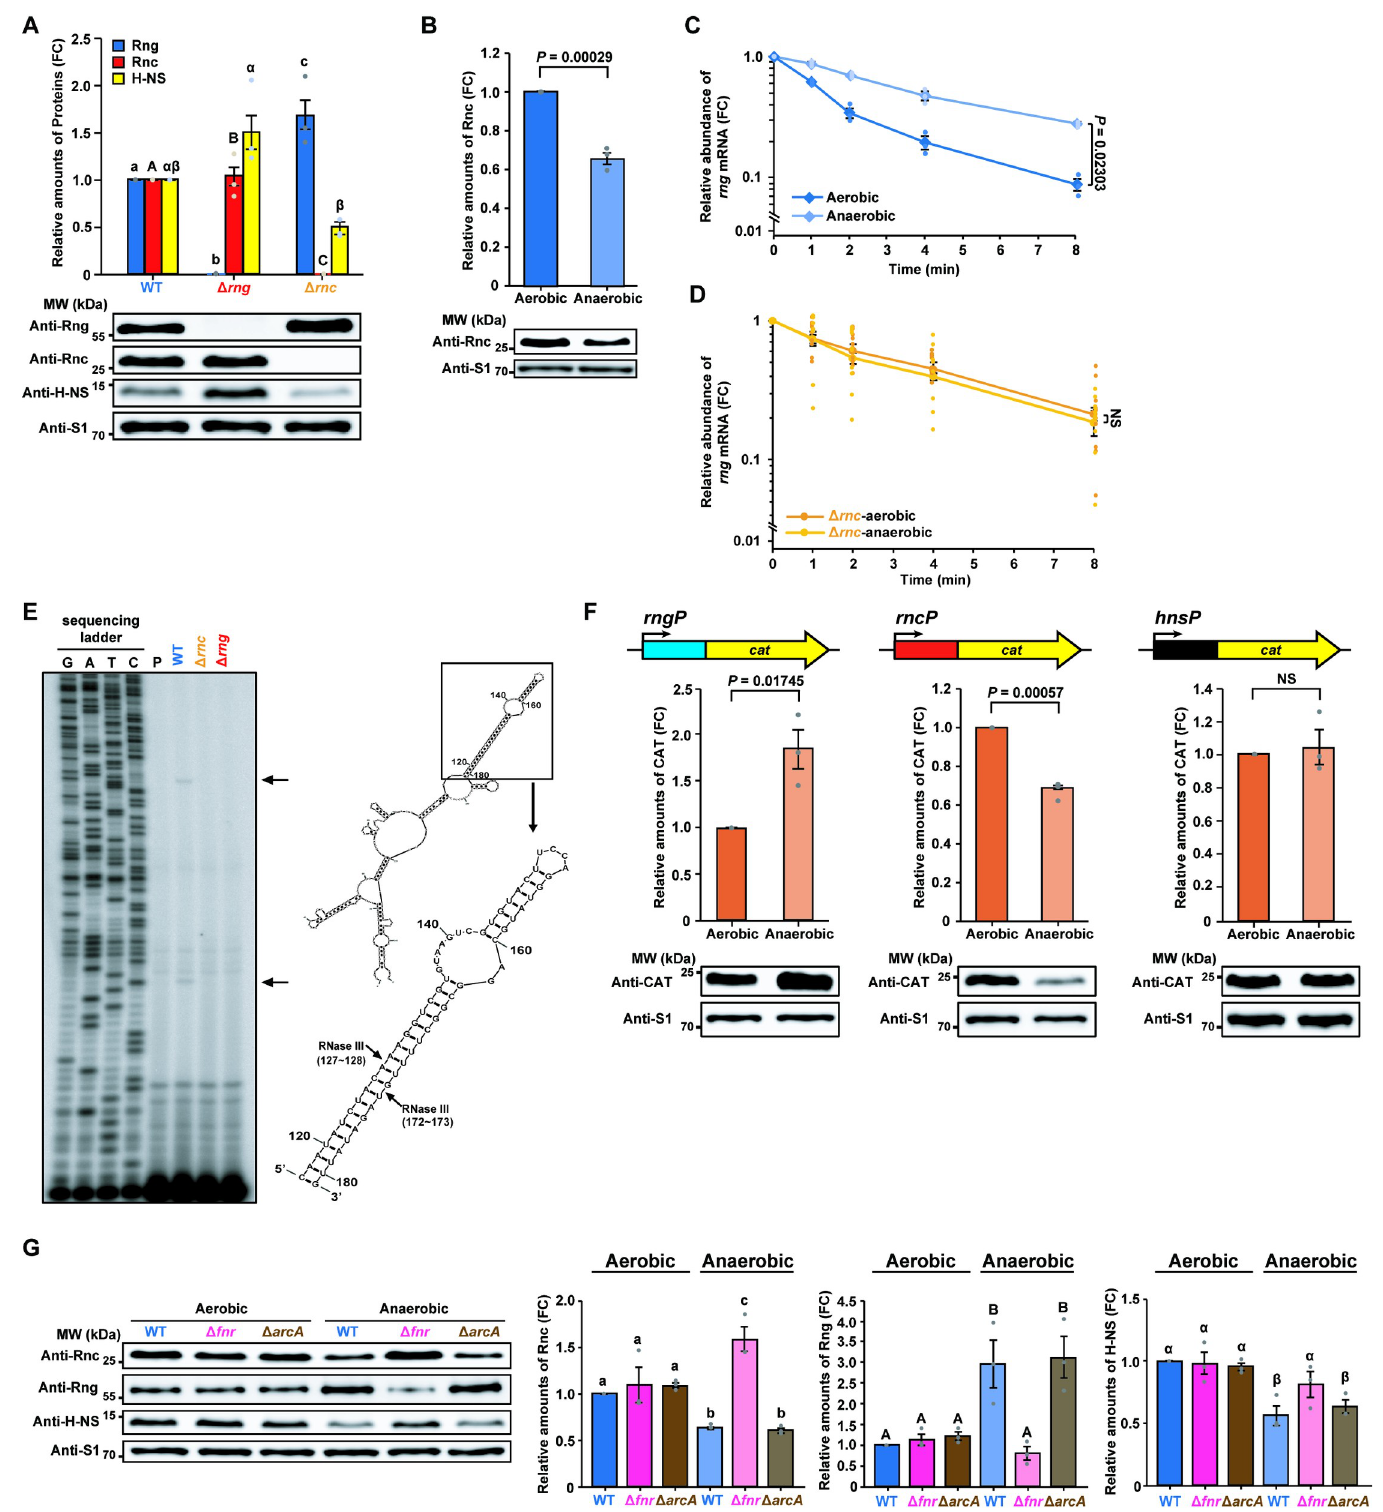
Fig 6. Increased RNase III activity down-regulates RNase G expression. (A) Western blot analysis of Rng, Rnc, and H-NS in S . Typhimurium strains (WT, Δ rng , and Δ rnc ). WT Rng, Rnc, and H-NS levels were set to 1. (B) Western blot analysis of Rnc levels in WT S . Typhimurium under aerobic and anaerobic conditions. Rnc levels under aerobic conditions were set to 1. (C) Effects of oxygen on rng mRNA stability in the S . Typhimurium cultures used in (B) measured by qRT-PCR. (D) Effects of